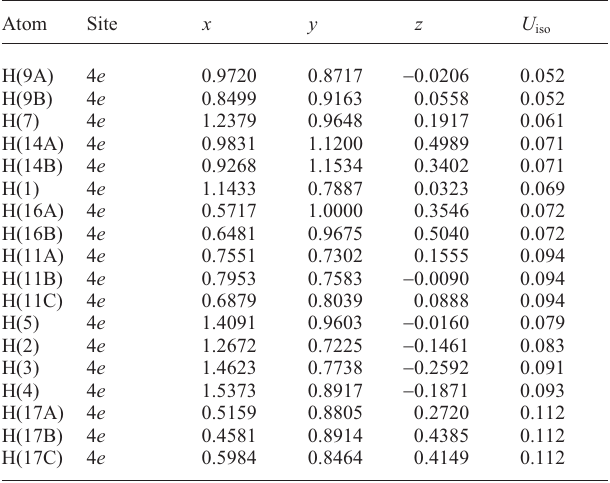
Table 2. Atomic coordinates and displacement parameters (in Å 2 ) . Atom Site x y